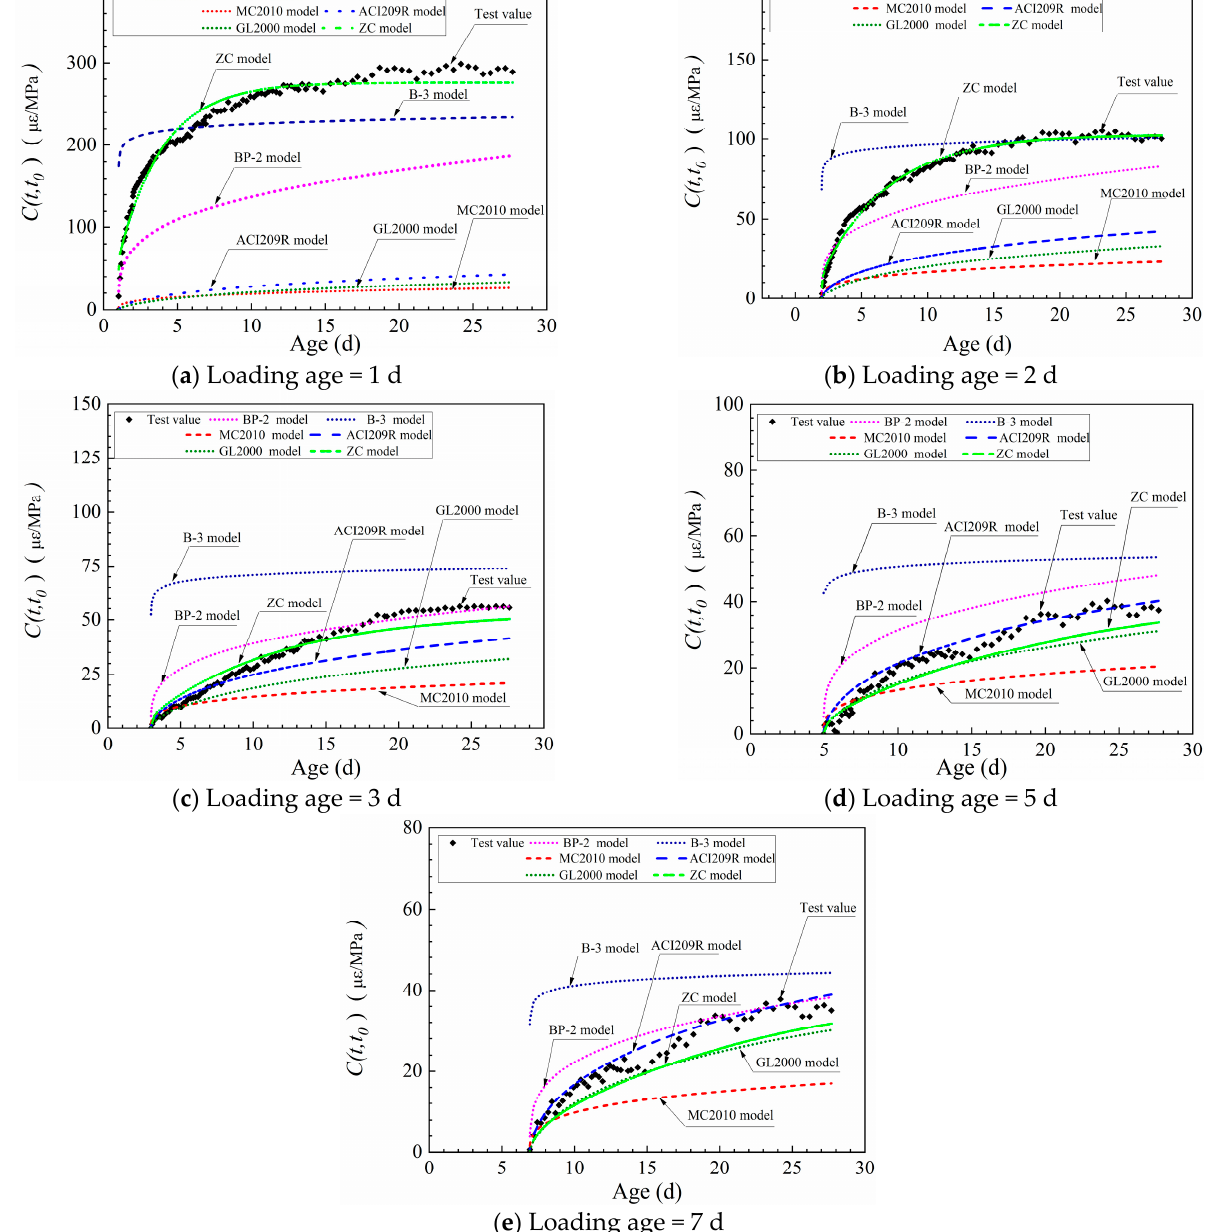
Figure 4. Comparison of specific creep models’ predicted values of FA30 with measured values.